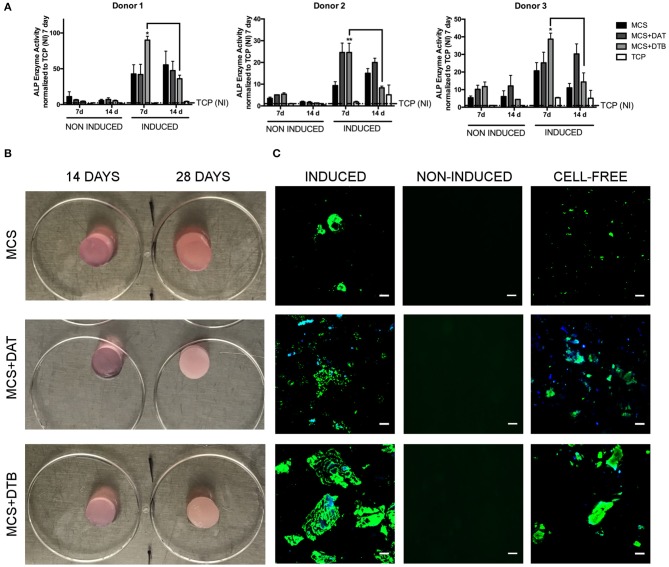
ASC expression of osteogenic markers was modulated by the incorporation of DTB within the hydrogel composites. (A) A peak in ALP enzyme activity at 7 d was observed in the MCS+DTB group cultured in osteogenic differentiation medium for all three ASC donors, suggesting that the DTB modulated osteogenic protein expression. Data is normalized to the non-induced (NI) TCP samples at 7 days. (*,**p < 0.05) (n = 3 samples per group/trial, N = 3 trials with different ASC donors) * statistically different than all other groups at 7 days, ** statistically different than all other groups except MCS+DAT at 7 days. Bars indicate a significant difference between 7 and 14 days (p < 0.05). (B) Macroscopic images of the MCS, MCS+DAT and MCS+DTB hydrogels at 14 and 28 days post-induction showing an increasingly opaque appearance in the hydrogels cultured in osteogenic medium, suggestive of matrix mineralization. (C) Positively-stained regions showing matrix mineralization (green) were observed at 28 days in the hydrogels cultured in osteogenic medium (induced), with qualitatively greater matrix mineralization around the ECM particles (blue) in the MCS+DTB composites. No staining was detected in the samples cultured in proliferation medium (non-induced controls). However, positive staining for matrix mineralization was observed in the cell-free hydrogel controls. Scale bar: 50 μm.